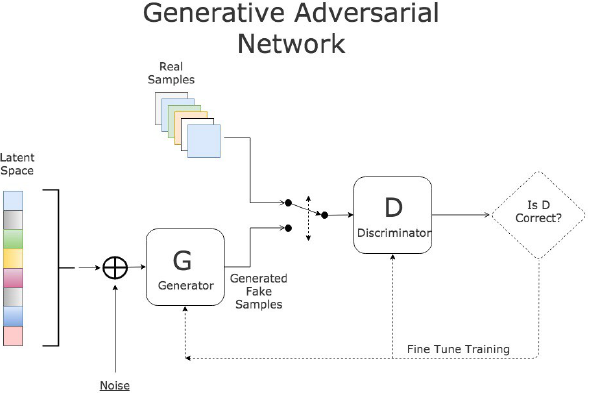
Figure 16. GAN architecture, accessed on 22 September 2022: